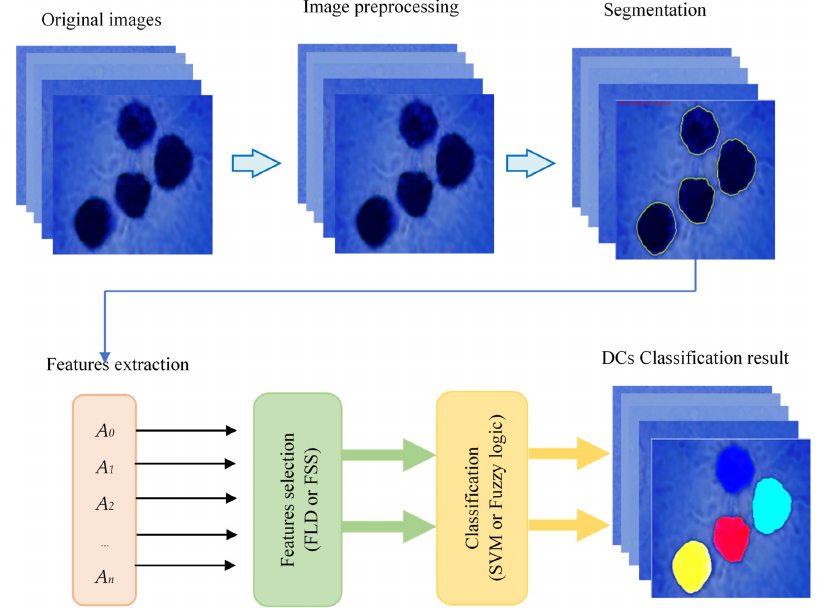
Figure 2. Flow chart of the proposed method of DCs classification. Table 2. Morphological features used to characterize dendritic cell shape.